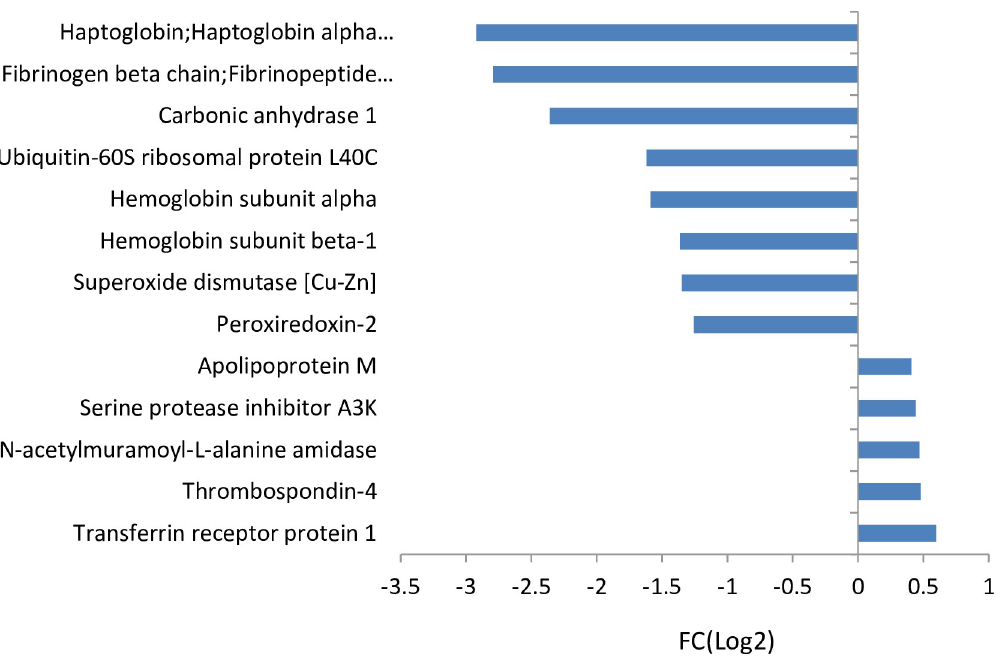
Fig 2. Protein fold changes (FC(Log2)) in plasma pre-metastasis (day 19) versus controls with p-value � 0.05 for Z- and t -tests.